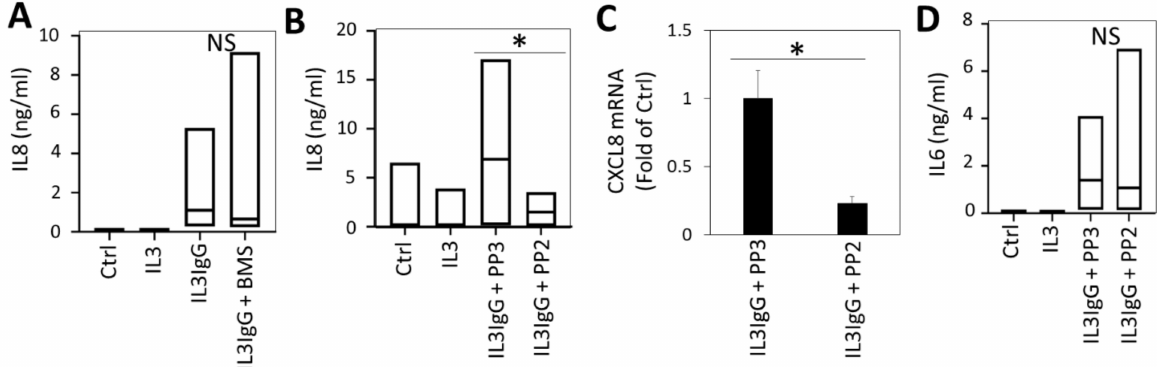
Figure 7. Eosinophil lysis products lead to the release of IL8 by human bronchial fibroblasts through the Src family kinase signaling mechanism. HBF were treated with I κ B kinase inhibitor (10 µ M BMS-345541 (BMS)), or vehicle (DMSO) ( A ), or inhibitor of Src-family kinases (10 µ M PP2 (or PP3 control)) ( B – D ) prior to stimulation with eosinophil supernatants. Twenty-four hours later, HBF lysates were assessed for levels of IL8 or IL6 ( n = 7 for all conditions in A; n = 3 for Ctrl and IL3 conditions and n = 4 for IL3IgG + PP3 and IL3IgG + PP2 conditions in ( B , D )) via ELISA ( A – D ). At the same time point, mRNA levels of CXCL8 in HBF ( n = 3 for all conditions) were assessed via RT-qPCR (mean ± sd). Paired ( A – D ) or unpaired ( C ) Student’s t -test was used to test for statistically significant differences (* p <